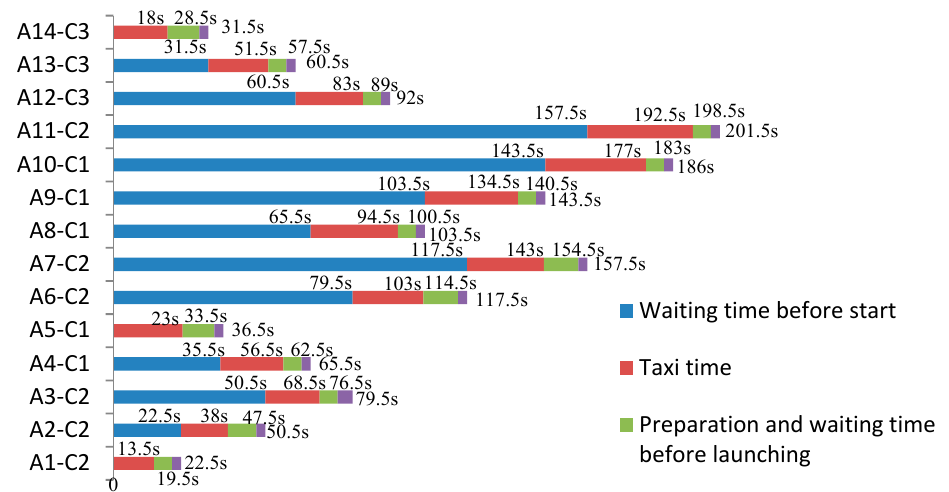
Mathematics 2018 , 6 , x FOR PEER REVIEW Figure 15.